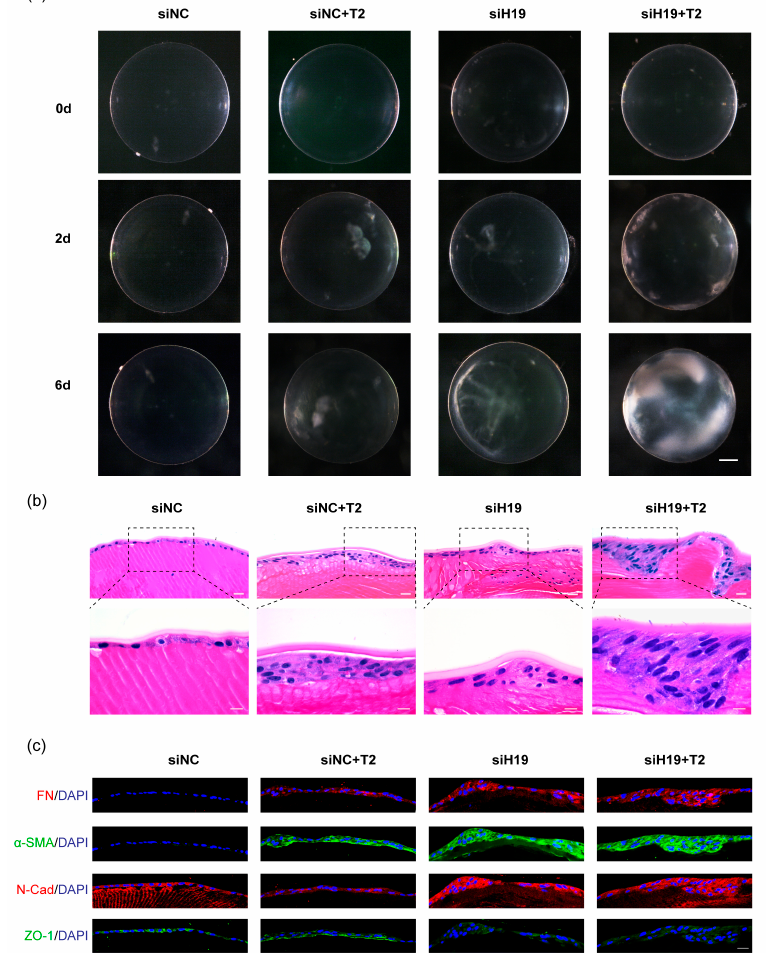
Figure 6. H19 was required to maintain LECs phenotype and lens clarity in semi-in vivo mouse whole lens cultures. ( a ) Images were taken by stereoscope with a dark background to demonstrate lens clarity. Scale bar, 200 μ m. ( b ) Hematoxylin and Eosin (HE) staining of the mouse whole lens explants was collected after being cultured for 6 days. Scale bars, 10 μ m. ( c ) Immunofluorescent staining of FN, α -SMA, N-Cad, and ZO-1 in freshly cut sections of the mouse whole lens explants was also collected on day 6 of culturing. Scale bars, 20 μ m.